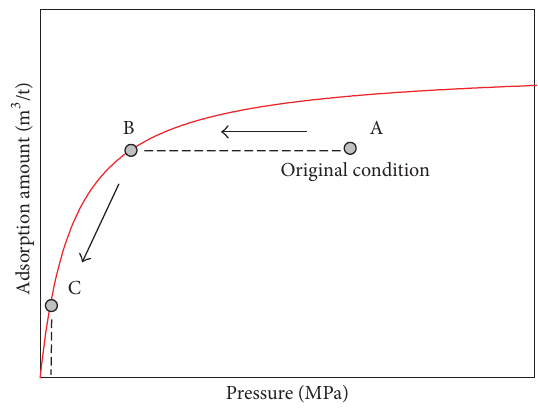
Figure 2: Langmuir isothermal adsorption